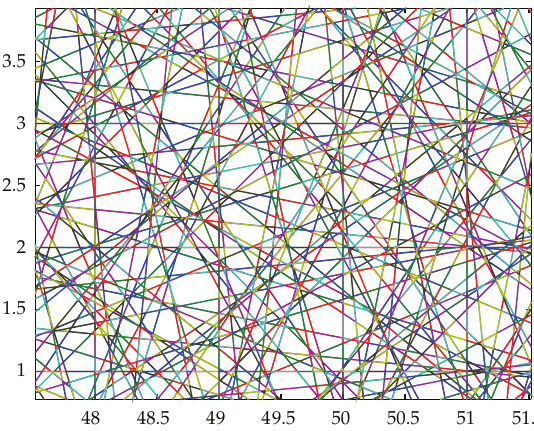
Figure 1: A detail in the J32M64